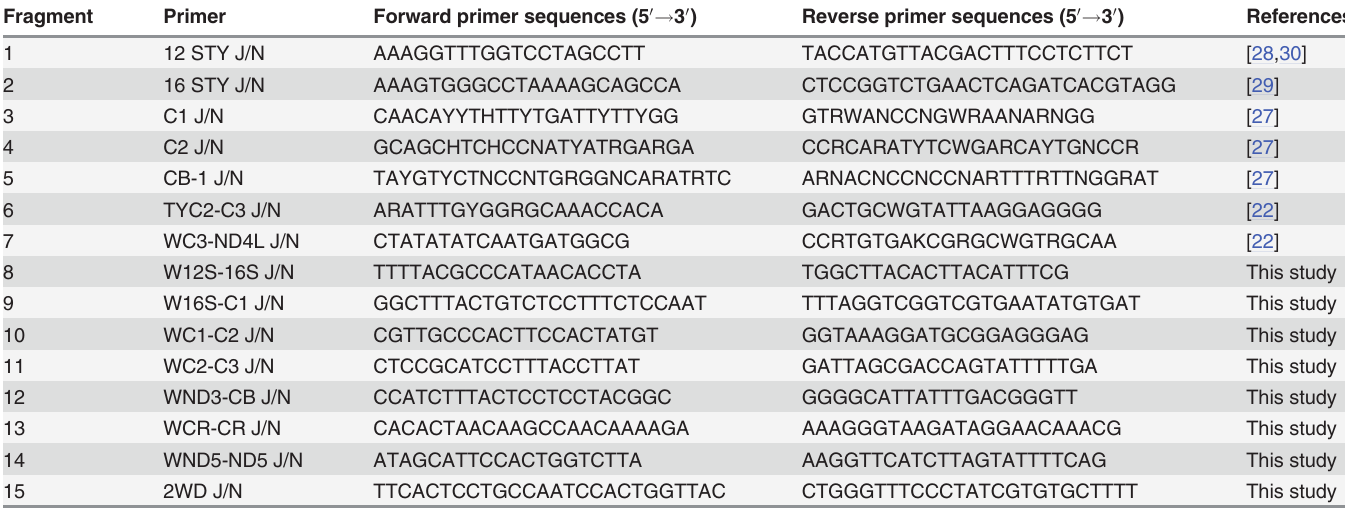
Table 1. Primer sequences used in this study.